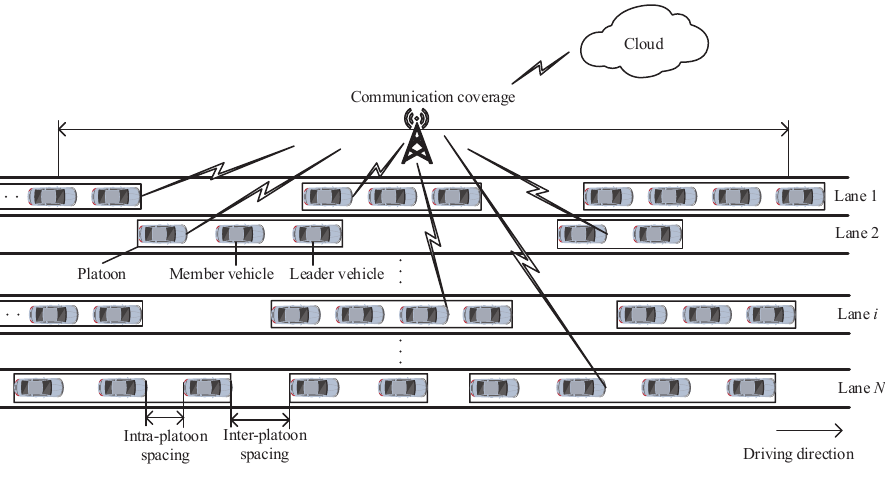
Figure 1. System